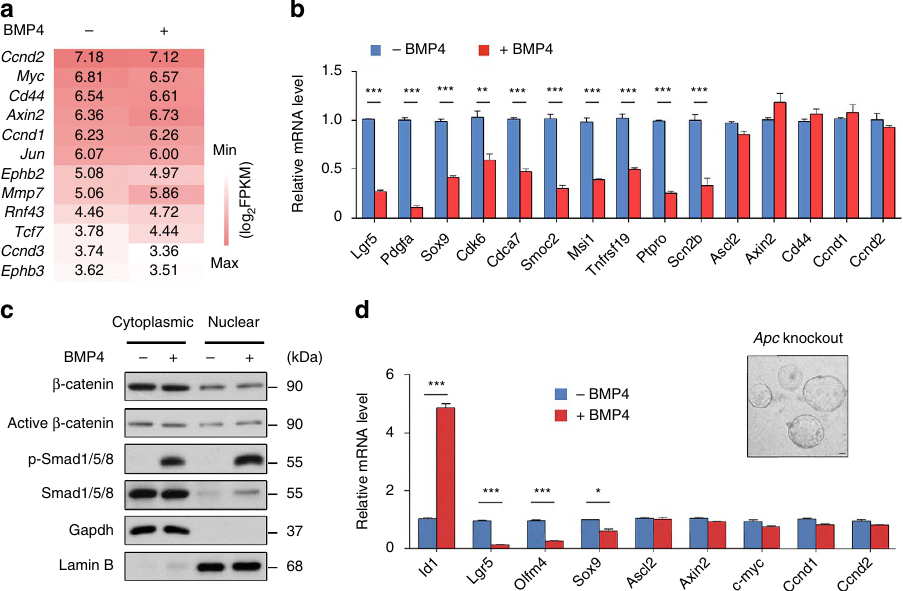
Figure 4 | BMP activation has no direct inhibitory effects on Wnt signalling in Lgr5 þ ISCs. ( a ) Heatmap showing the expression levels of several canonical Wnt target genes in Lgr5 þ stem cells on BMP stimulation. ( b ) Quantitative RT–PCR verification of BMP-regulated genes and Wnt target genes in Lgr5 þ stem cells. Data represent mean ± s.e.m of n ¼ 3 independent experiments. *** P o 0.001 by Student’s t -tests. ( c ) Immunoblots of cytoplasmic and nuclear proteins from intestinal organoids treated with or without BMP4 for 4h. Data are representative of three independent experiments. ( d ) Quantitative RT–PCR analysis of gene expression in Apc mutant organoids derived from intestinal tumours in Vil-cre;Apc wt/fl mice that were treated with or without BMP for 4h. Data represent mean ± s.e.m of three independent experiments. * P o 0.05, ** P o 0.01, *** P o 0.001 by Student’s t -tests. Scale bar, 50 m